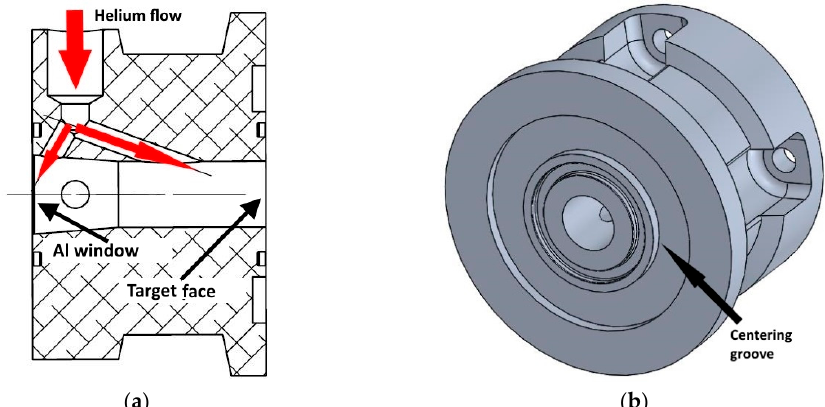
Figure 6. ( a ) Helium window showing the two channels that guide the helium flow into the center of the aluminum foil on the left and the target plate on the right (cross-section). ( b ) Helium window inner